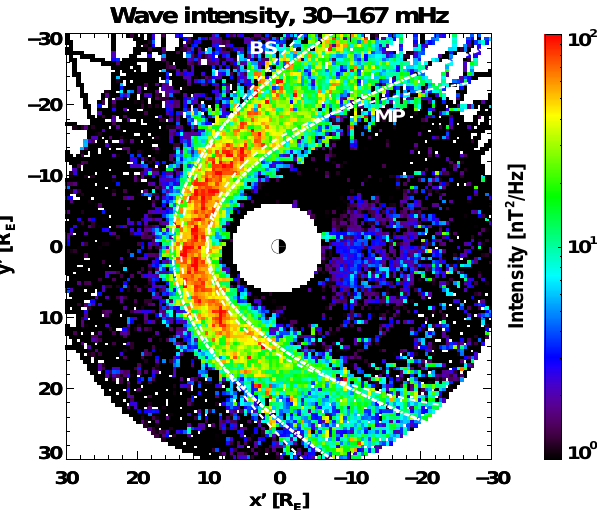
Fig. 4. Spatial distribution of the wave intensity in the ecliptic plane (after Guicking,